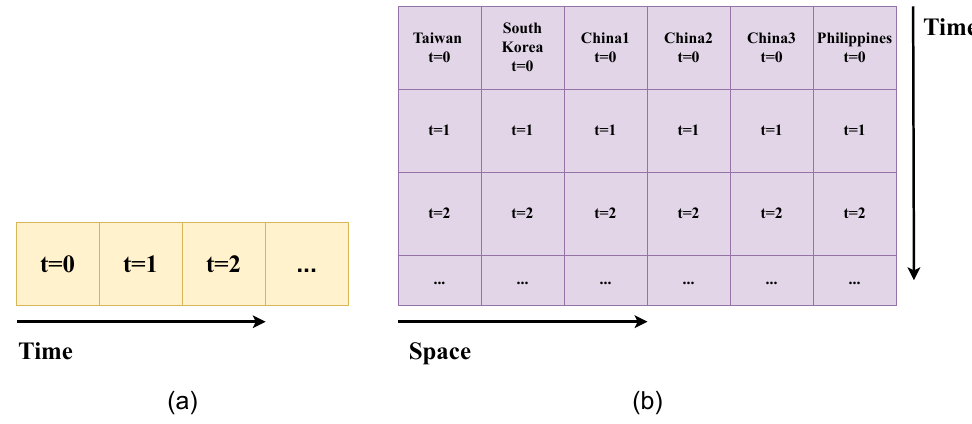
Figure 7. Schematic of input data of 1D ( a ) and 2D ( b ) CNNs for wind